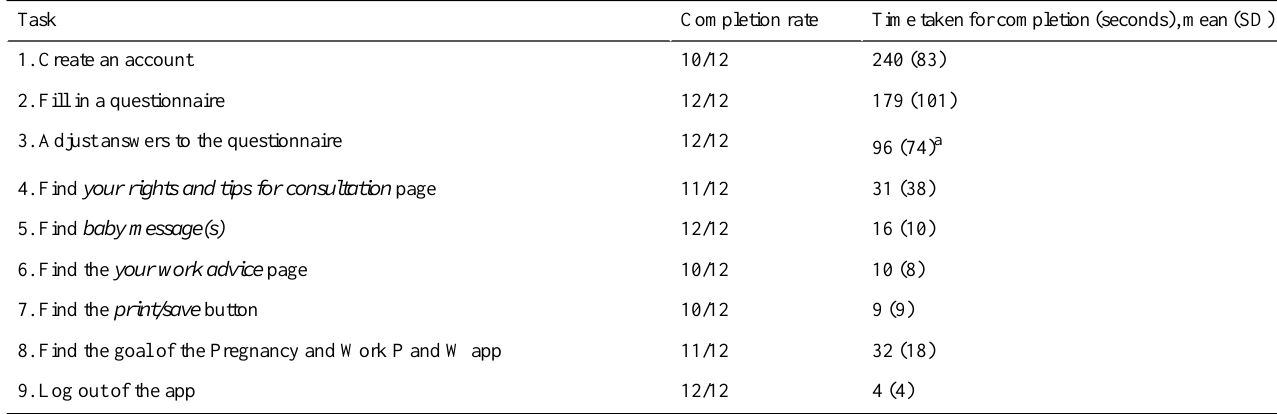
Table 2. Completion rates and time taken per task (N=9) by